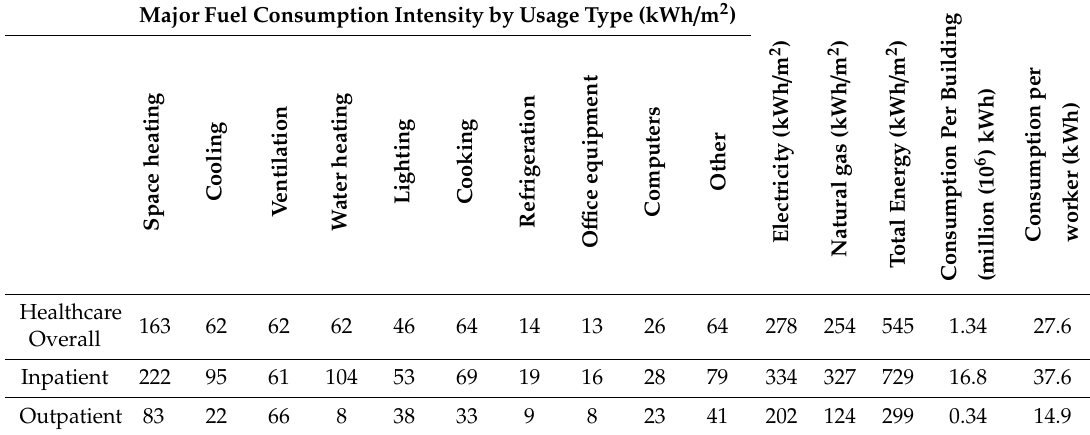
Table 2. Energy consumption intensity.